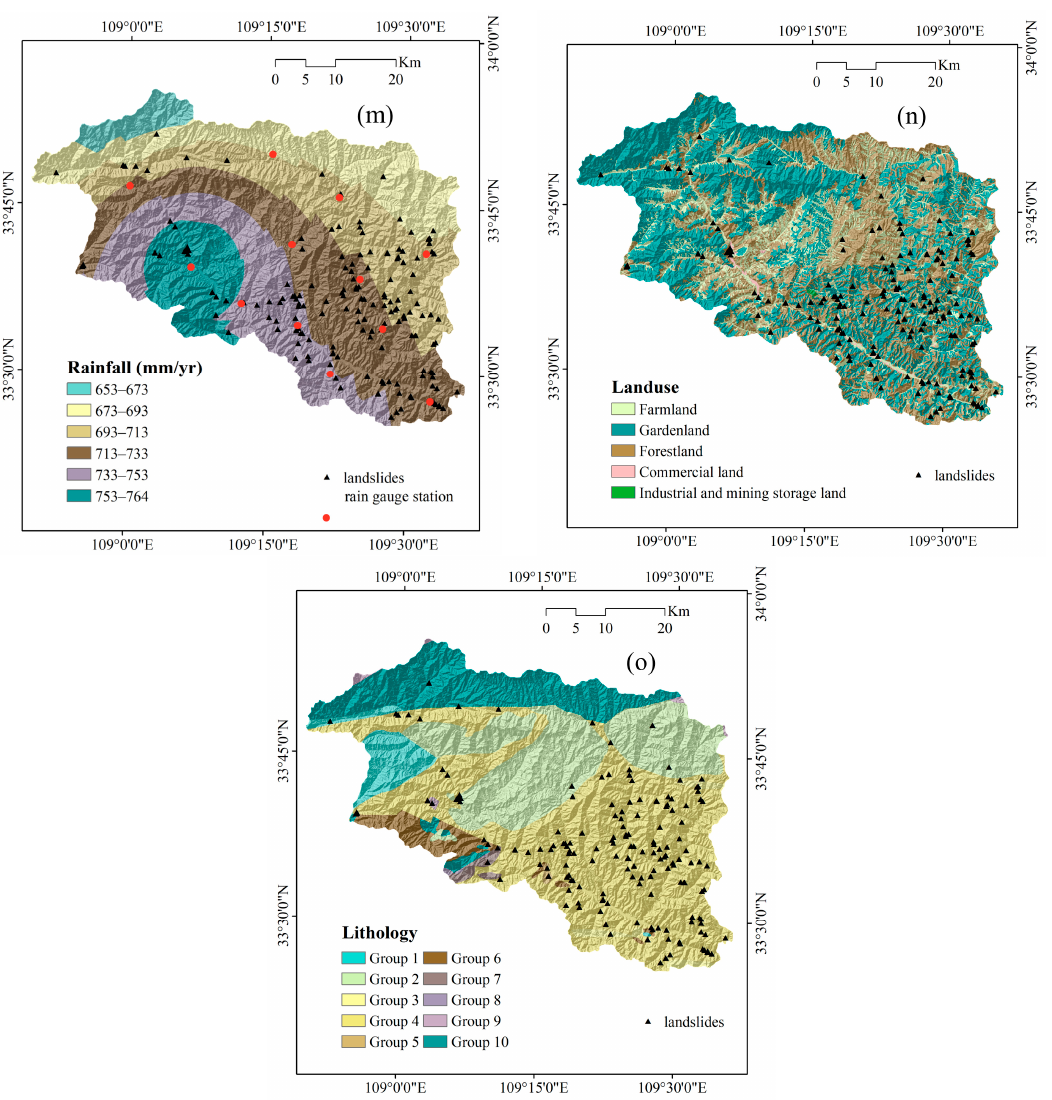
Figure 3. Thematic maps: ( a ) elevation; ( b ) slope angle; ( c ) slope aspect; ( d ) profile curvature; ( e ) plan curvature; ( f ) TWI; ( g ) SPI; ( h ) STI; ( i ) distance to faults; ( j ) distance to roads; ( k ) distance to rivers; ( l ) NDVI; ( m ) rainfall; ( n ) land use; ( o ) lithology.